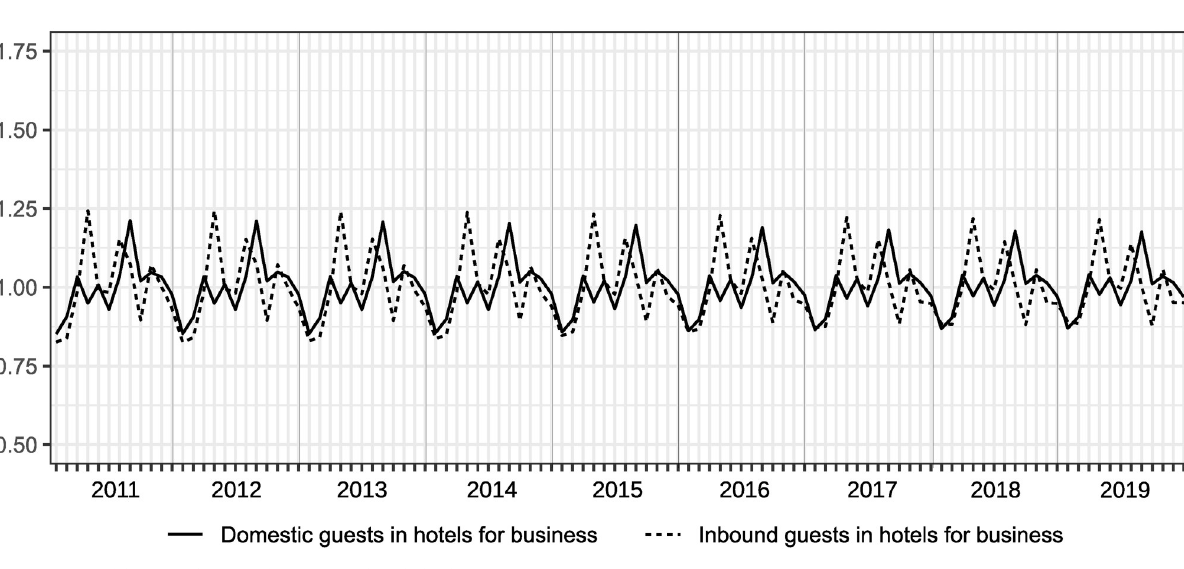
Fig 4. Seasonal factors of overnight guests in hotels for business over 2011 to